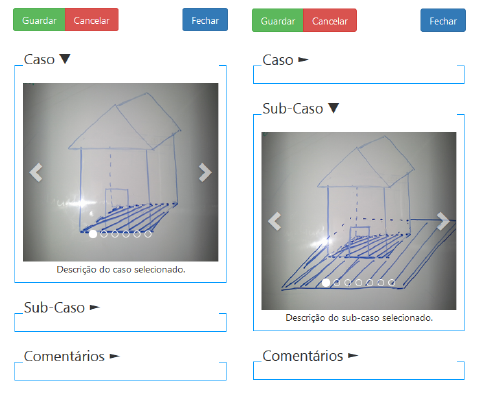
Figure 3: Two Tier Property Case Selection, with a comment op- tion